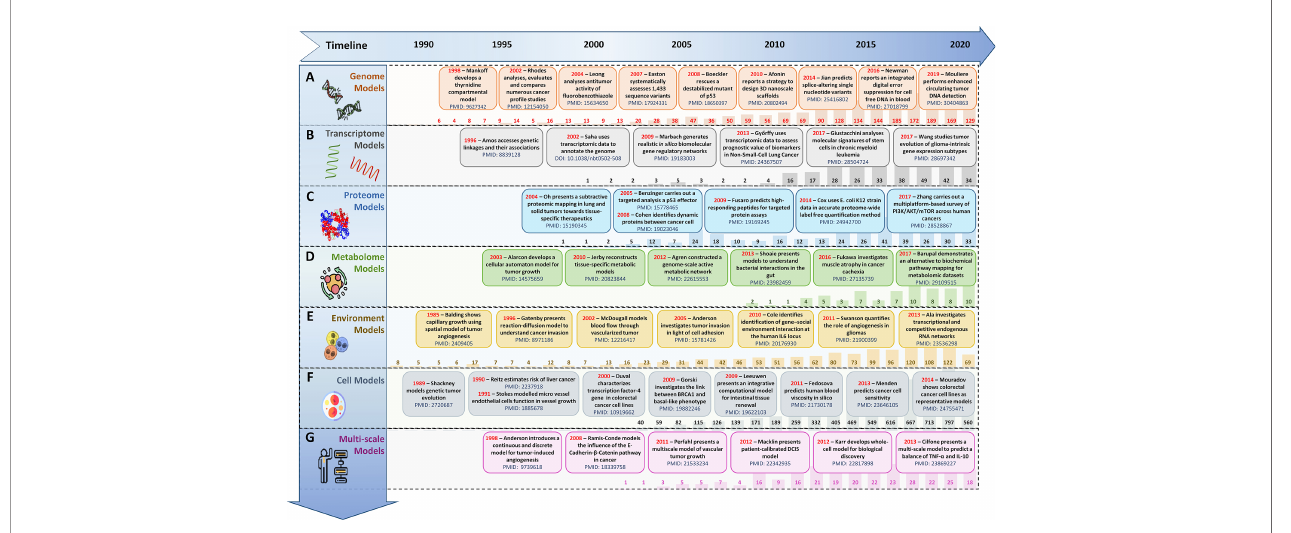
FIGURE 2 | Evolution timeline of in silico scale-speci fi c and multi-scale data-drive cancer models. Timeline of salient in silico scale-speci fi c and multi-scale cancer models, along with PubMed yearly report (1990-2020) to display the evolutionary trends seen in the development of (A) genome-scale cancer models, (B) Transcript-level cancer models, (C) Proteome-scale models, (D) Metabolome scale models, (E) Environment-based models, (F) Cell-level models, and (G) Multi-scale cancer